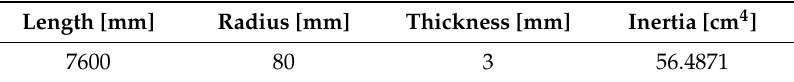
Figure 5. First test – structural scheme. Table 2. First test: Specimen parameters.